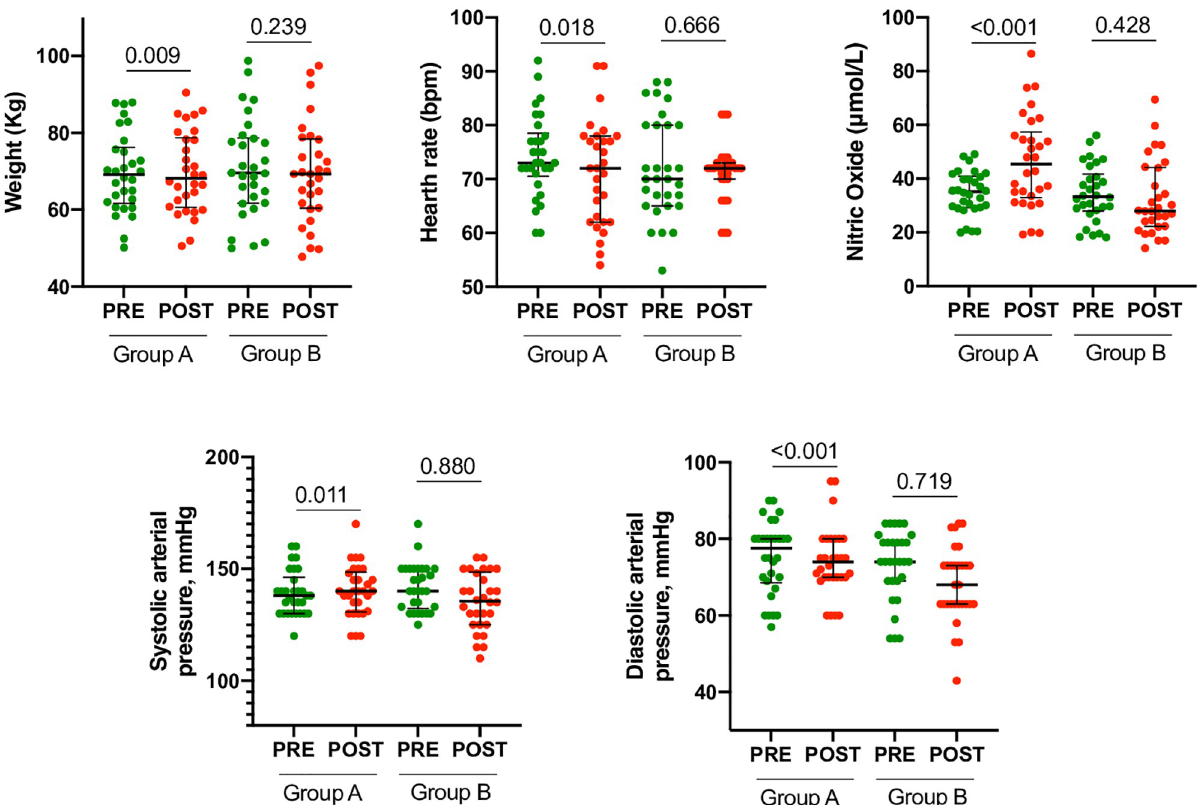
Fig 2. Clinical and laboratory characteristics in Group A e B, pre and post, PESF or not. Body weight, systolic and diastolic pressure, heart rate changes significantly reduced, while Nitric Oxide increased only in Group A post treatment. Significance was calculated by Mann-Whitney U